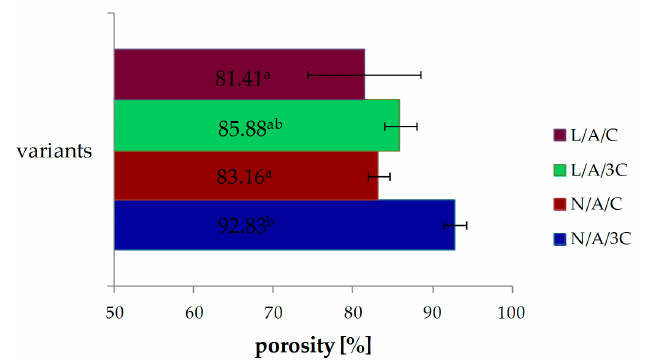
Figure 1. Effect of various sponges’ compositions on porosity, a–b values with different letters within the same column differ significantly ( p < 0.05). the same column differ significantly ( p <